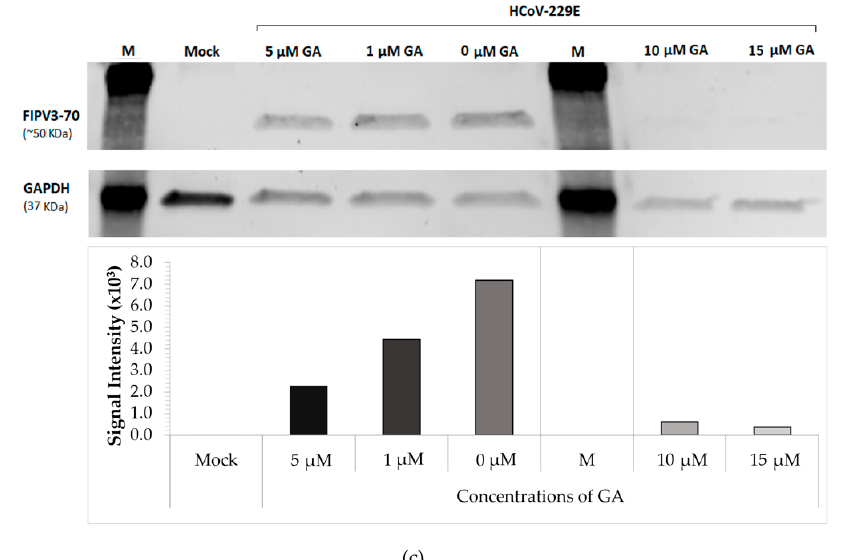
Figure 1. Dose-dependent response of GA in HCoV-229E-infected MRC-5 cells. ( a ) Representative light microscopy images of cytopathic effect (CPE) caused by HCoV-229E-infected MRC-5 cells treated with respective concentrations of GA on day 6 post-infection (pi); ( b ) supernatant viral load of infected MRC-5 cells treated with increasing concentrations of GA across the indicated time points, compared to day 0; ( c ) Western Blot analysis using antibodies directed against coronavirus (FIPV3-70); M: Chameleon 800 Pre-stained Protein Ladder. Band signaling intensities for FIPV3-70 antibody have been normalized to GAPDH. Mixed-model ANOVA [Interaction (Time*Treatment): [ p < 0.0001]; treatments (0, 1, 5, 10, 15 µM GA): [ p < 0.0001]; and time (0, 3, 6 days): [ p < 0.0001]). **** p < 0.0001, represent a significant decrease in viral load under each concentration compared to 0 µM GA at day 6 pi.